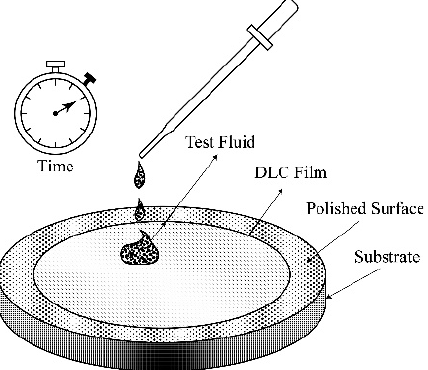
Figure 3. Diagram representing the chemical test procedure